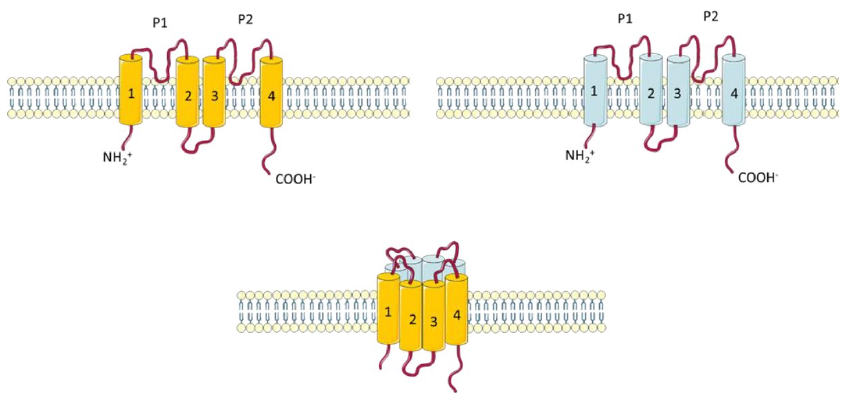
Figure 4. General molecular architecture of two pore potassium channels (K 2P ). K 2P channels need homodimerization or heterodimerization to form a functional channel (different colors represent different K2P subunit).